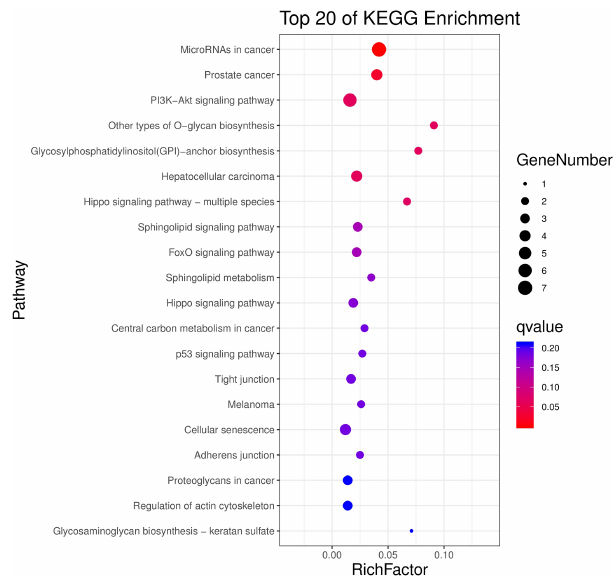
Figure 7. Seventy-three target genes were conducted using KEGG signaling pathway enrichment analysis. P value < 0 . 05 was consid- ered statistically